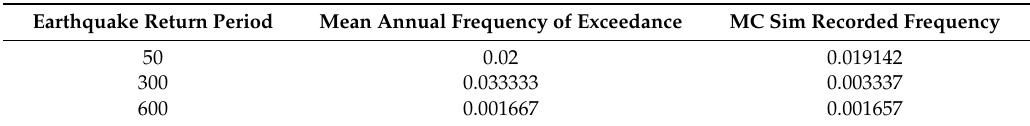
Table 12. Comparison with Mean Annual Frequency of Exceedance from probabilistic seismic hazard analysis model and frequency recorded by Monte Carlo (MC)